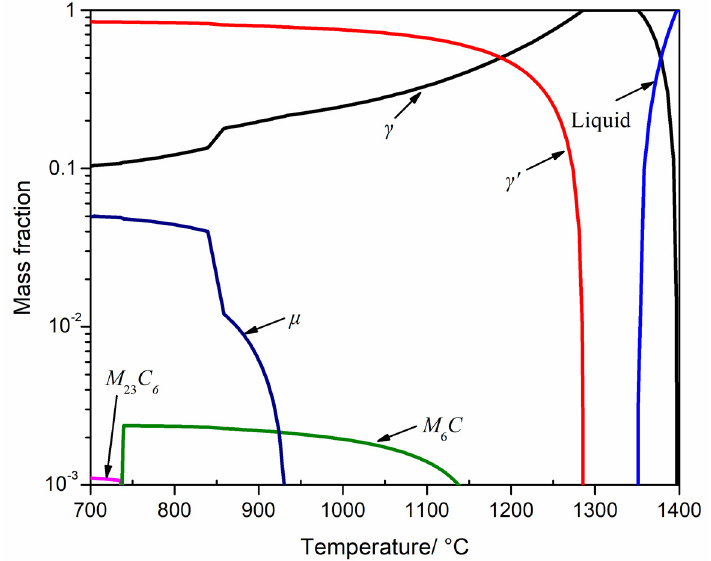
Figure 3. Phase equilibrium diagram of the experimental superalloy between 700 °C and 1400 °C using Pandat software 2018 version based on PanNi 2018 database.